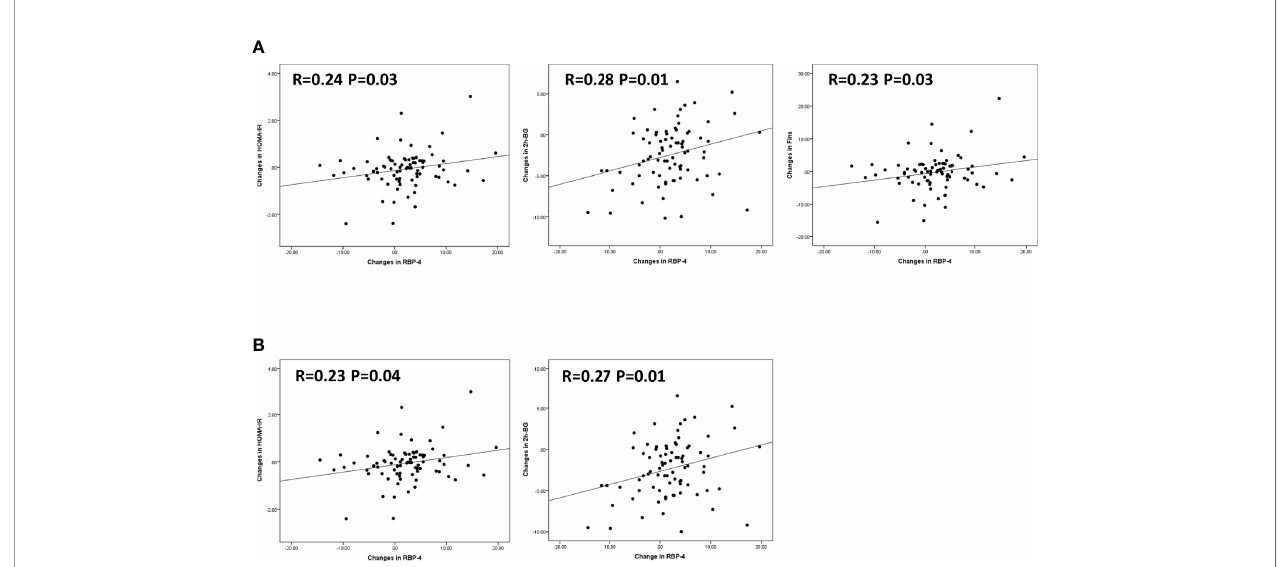
FIGURE 4 | Correlation between changes in serum RBP-4 levels and various insulin sensitivity parameters. (A) Changes in HOMA-IR, 2h-BG, and Fins showed positive linear correlations with changes in RBP-4 levels in linear regression. (B) With adjustment for gender, age, and BMI, changes in HOMA-IR, and 2h-BG showed positive linear correlations with changes in RBP-4 levels in linear